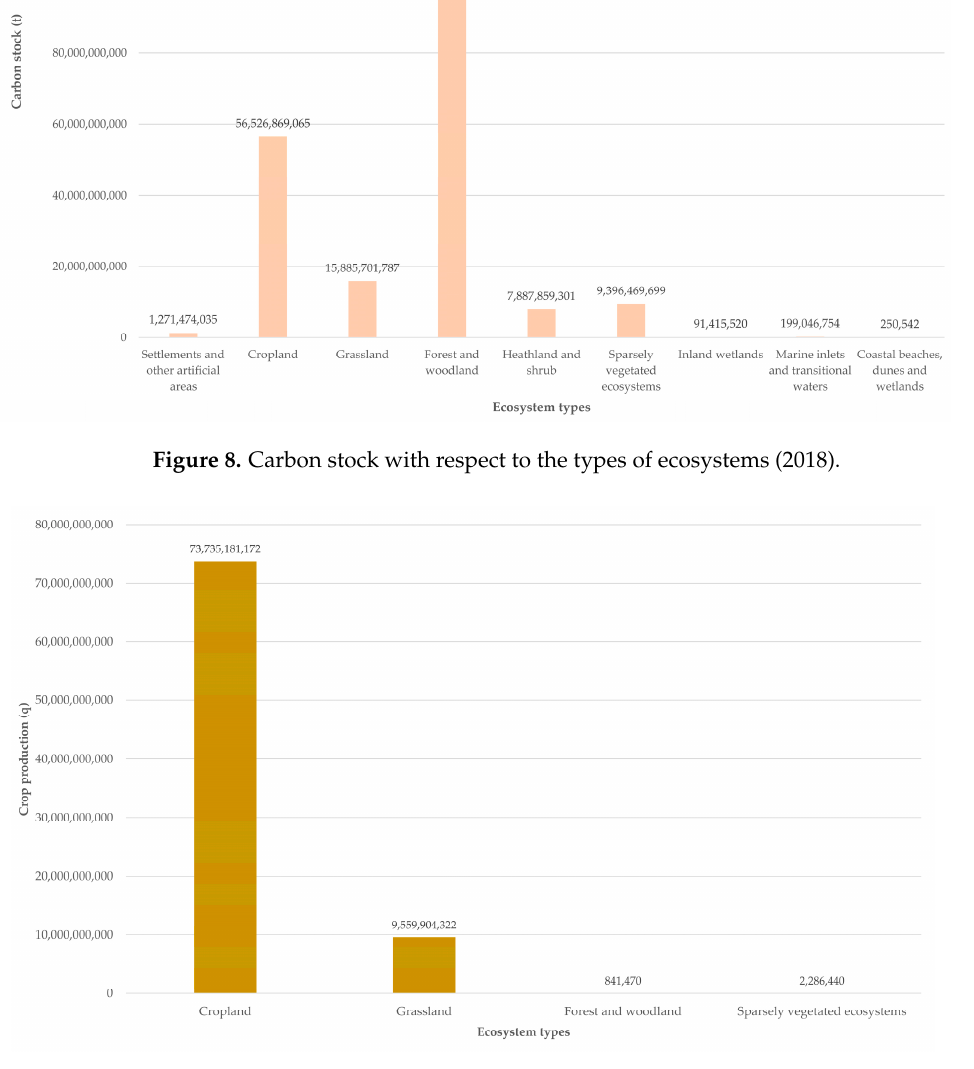
Figure 9. Crop production with respect to the types of ecosystems (2018).